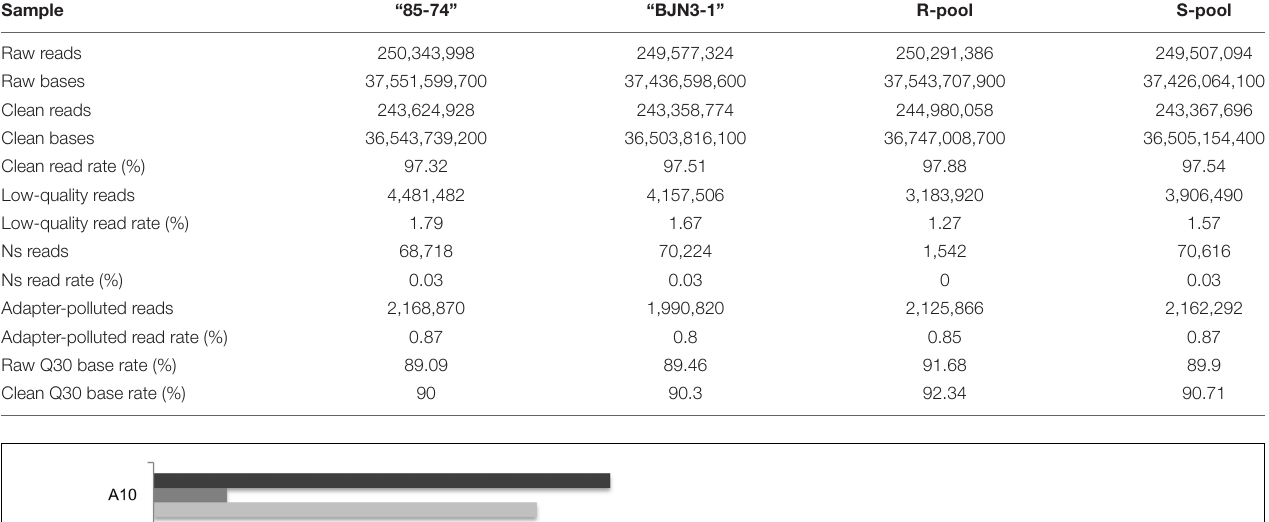
TABLE 3 | Quality control of sequencing data.